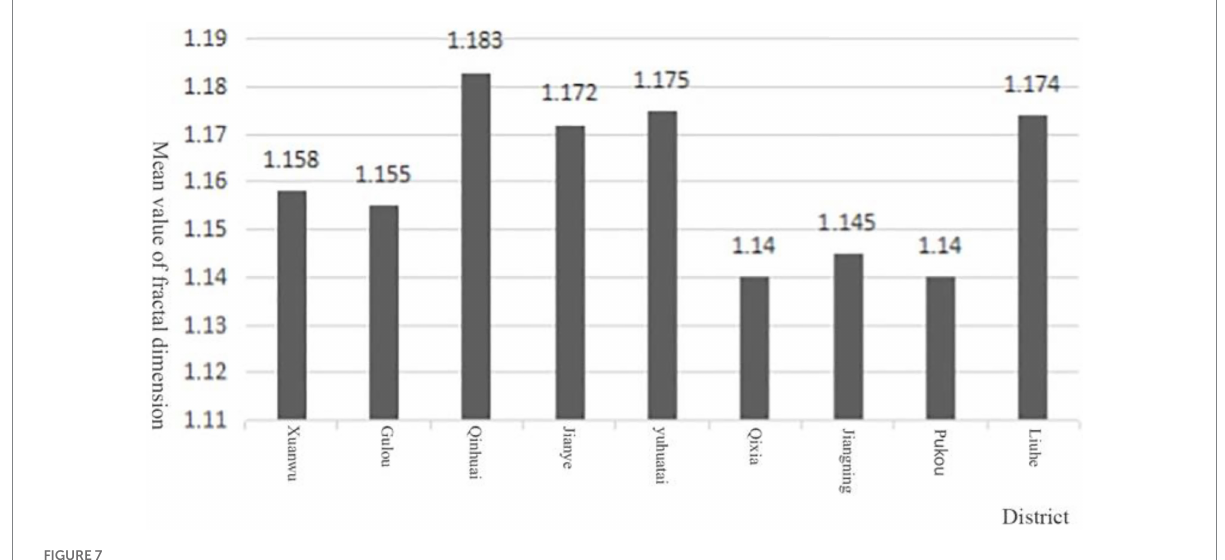
FIGURE 7 Mean value of fractal dimension.